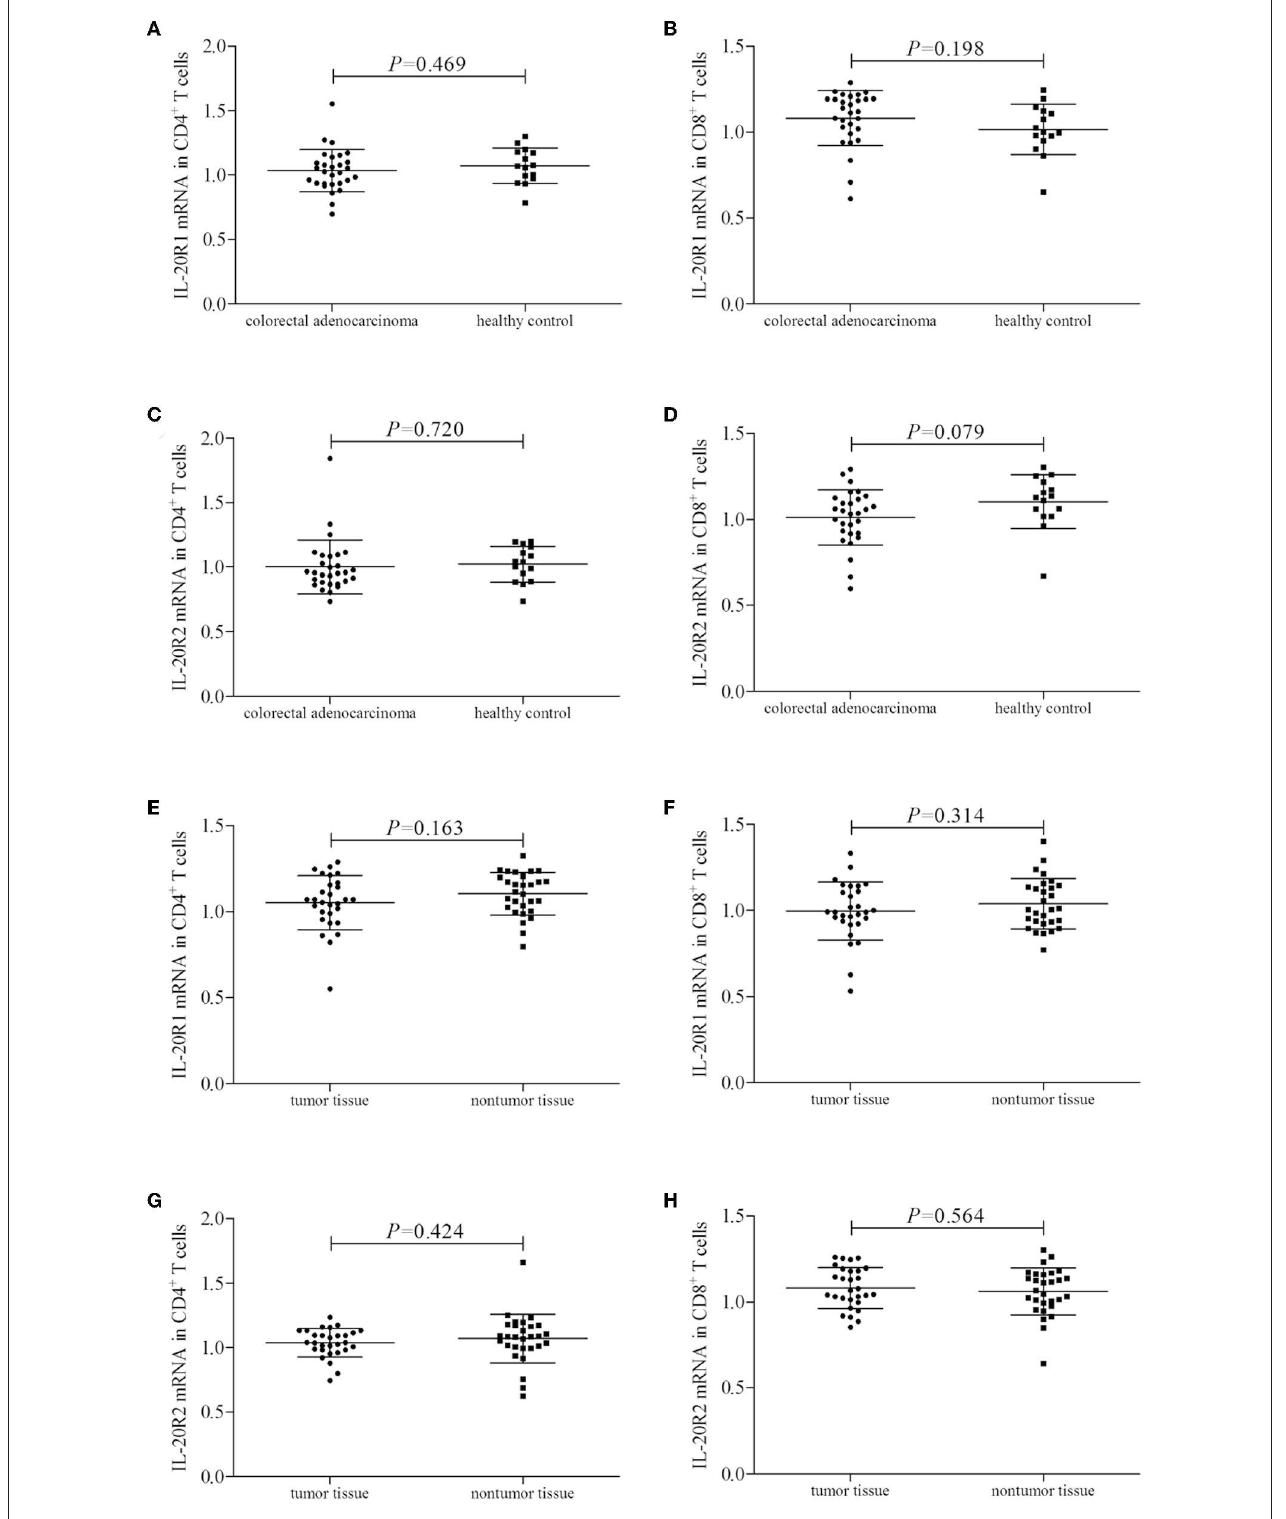
FIGURE 2 | IL-24 receptor component expression in colorectal adenocarcinoma patients. IL-20R1, IL-20R2, and IL-22R2 mRNA relative level was semi-quantified in peripheral and tumor-infiltrating CD4 + and CD8 + T cells from all enrolled subjects (29 of colorectal adenocarcinoma patients and 15 of healthy controls). (A)